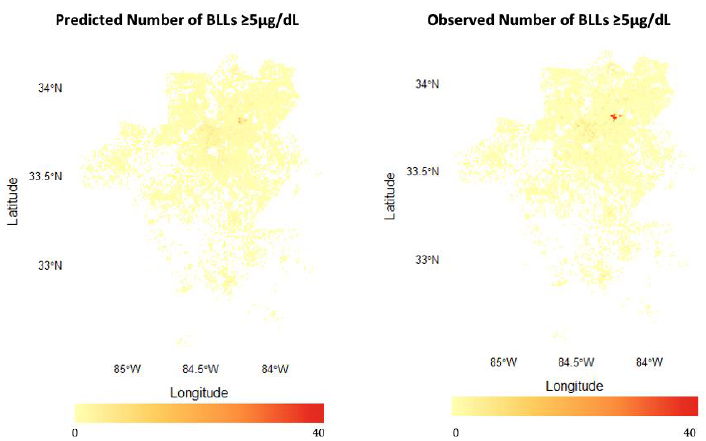
Figure 7. Raster grid of predicted and observed number of BLLs ≥ 5 µg/dL in the Atlanta metro area.